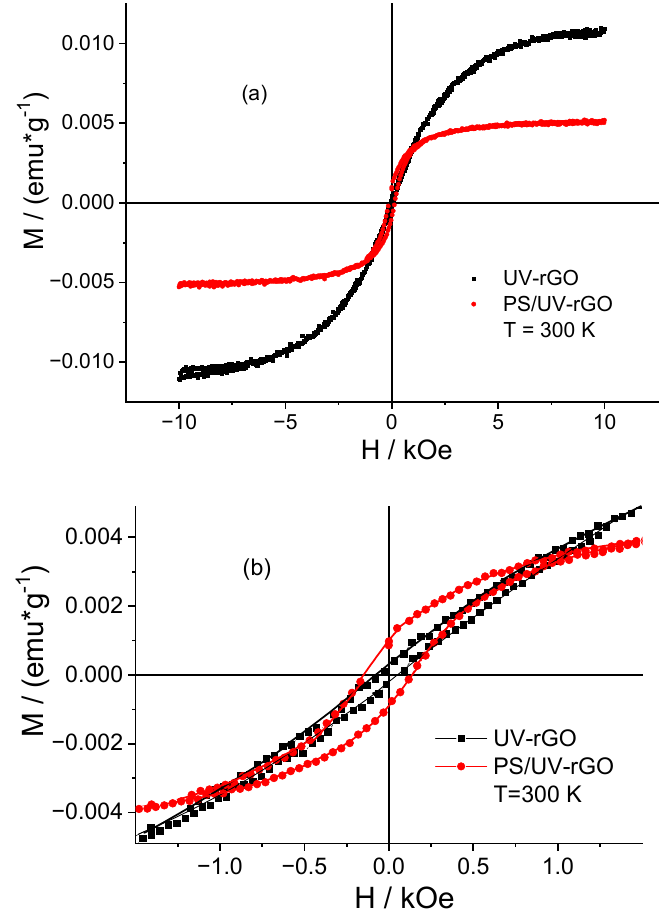
Figure 7. Magnetic field dependences of the specific magnetic moment for UV-rGO-flakes (black curve) and their composite (red curve) based on nonmagnetic PS at various scales ( a,b ).